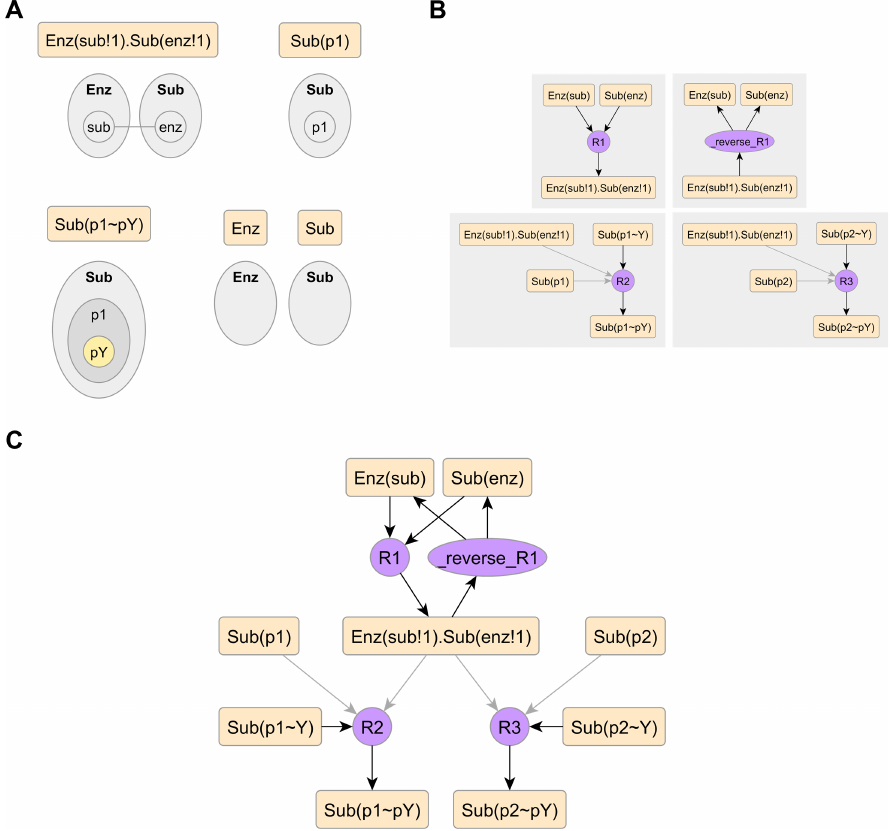
Fig 3. Atom-rule (AR) graphs. (A) Atoms, which are elementary structural features, shown in BioNetGen syntax and graphic. (B) Atom-rule graphs derived from the individualrules in Fig 2B. (C) The full atom-rule graph of the model, mergedfrom individualgraphsin panel B. AR graphshave three edge types: reactant (dark color, pointedtowards rule), product (dark color, pointedaway from rule), and context (light color, pointedtowardsrule), which indicatewhether an instance of an atom is present in the rule’s reactioncenter (reactant/product) or reaction context.